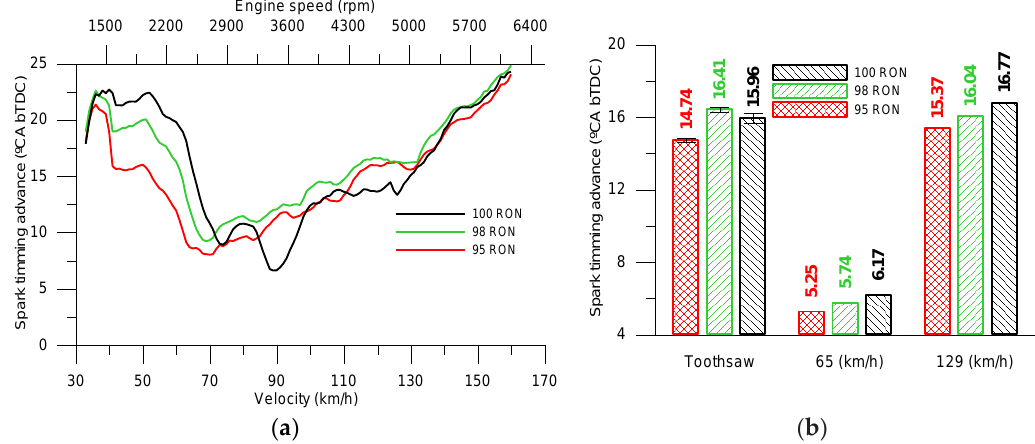
Figure 6. ( a ) Spark ignition advance along the toothsaw, ( b ) average spark ignition advance along toothsaw and steady-state modes.